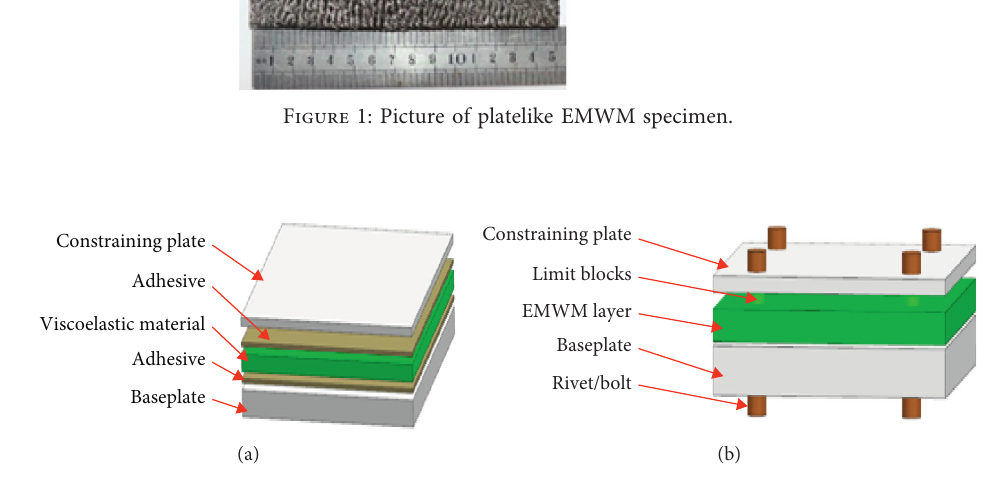
Figure 2: Sketches of two kinds of composite structures. (a) Composite structure with viscoelastic core. (b) Composite structure with EMWM